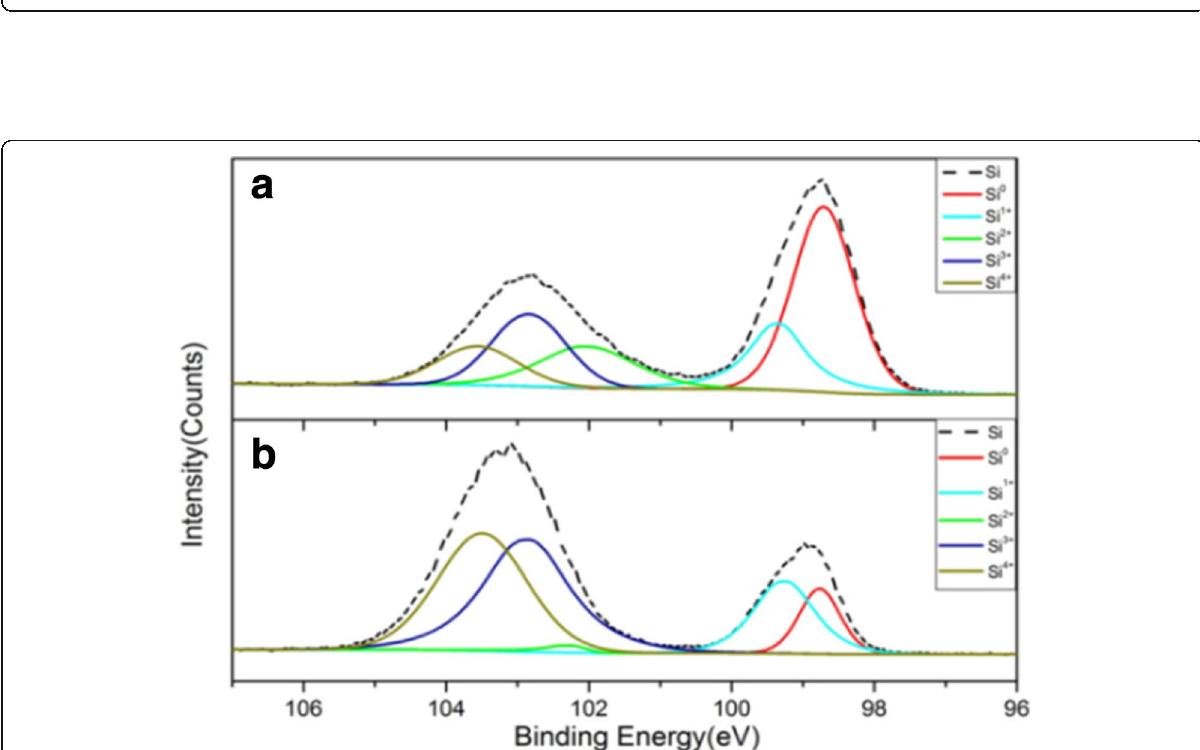
Fig. 1 a Schematic illustration for nano-Si/SiO x formation and further Si/C yolk/shell structure formation. b SEM image of nano-Si/SiO x sample. c Real sample images